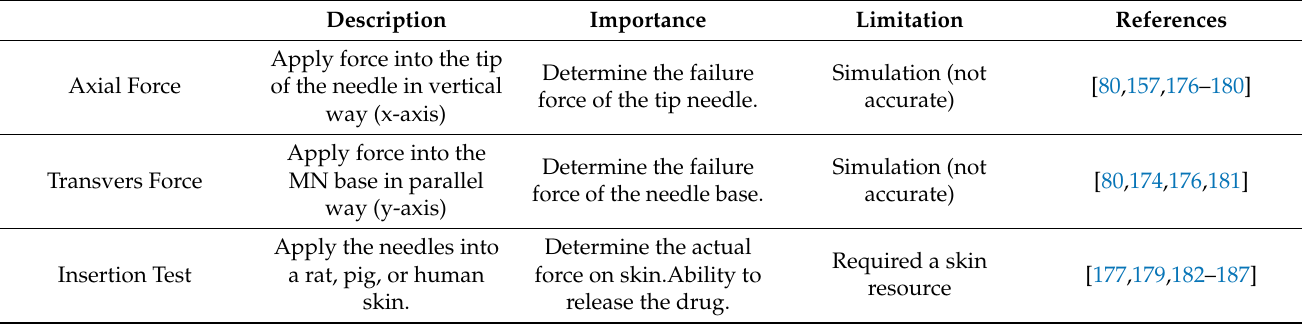
Table 4. Overview: MN Mechanical